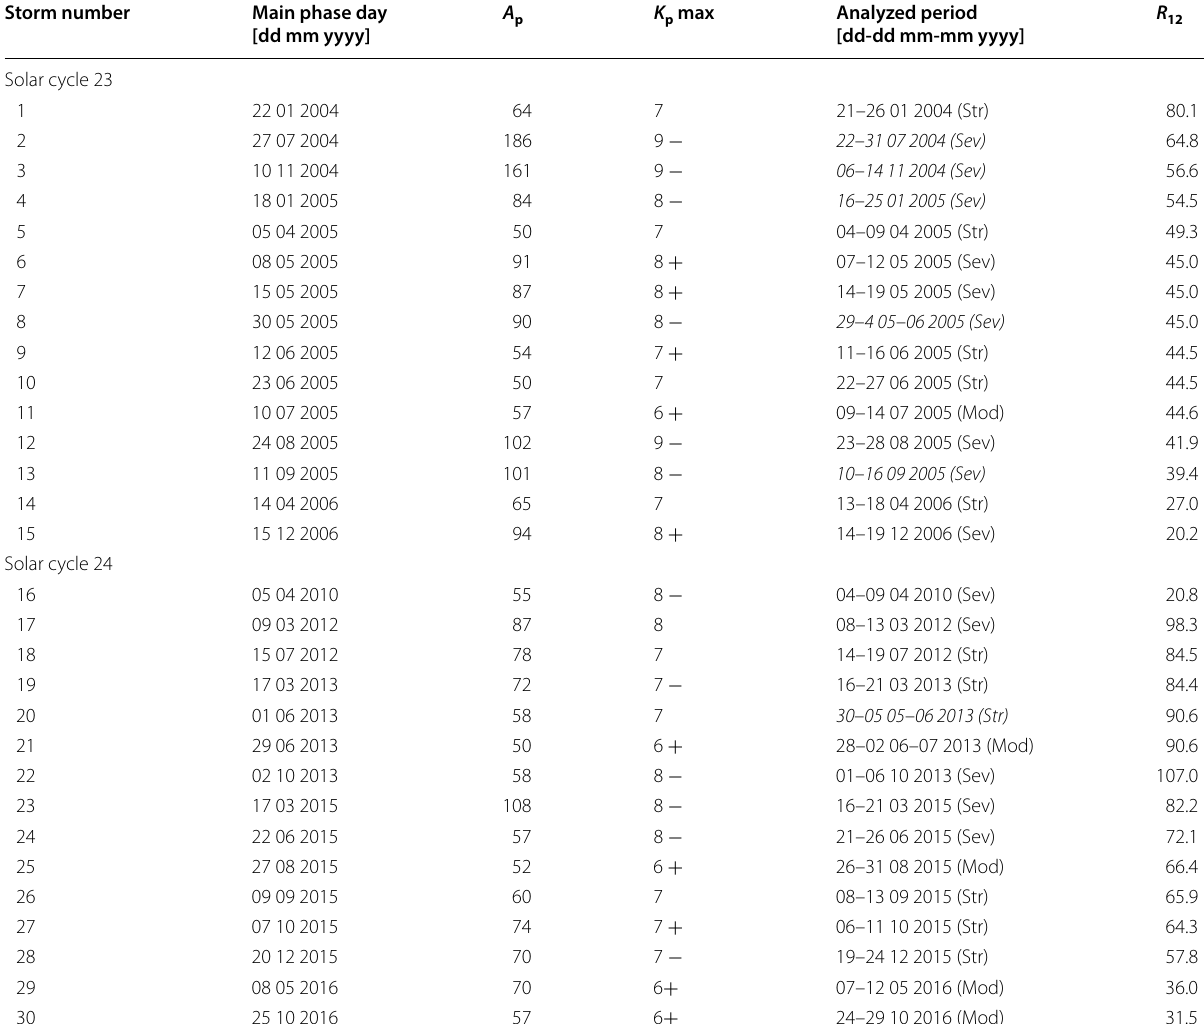
Table 3 Storm time periods analyzed in this